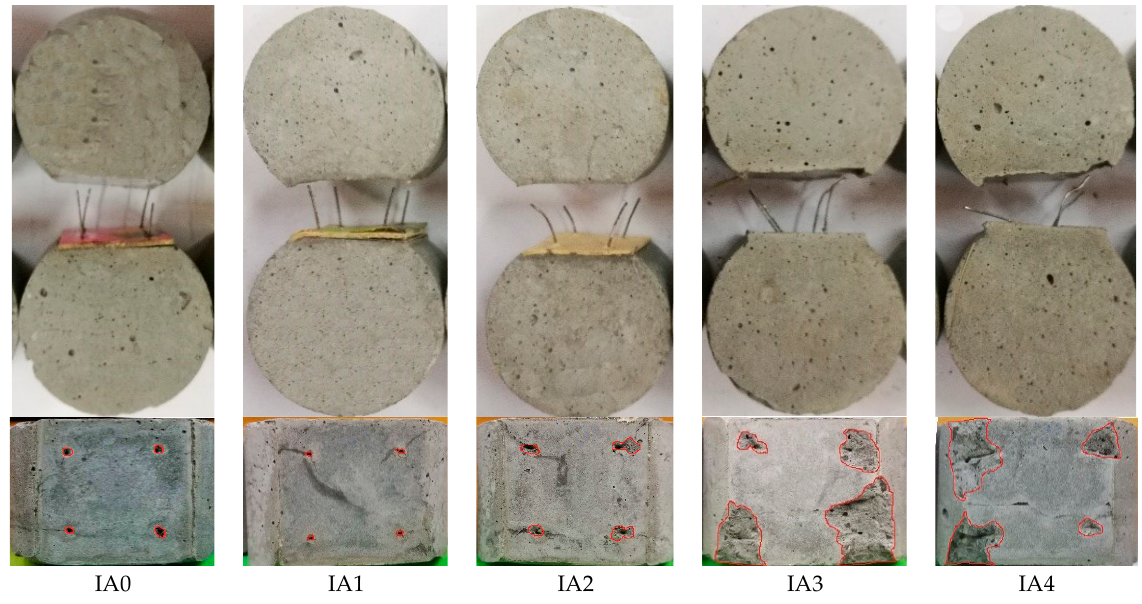
Figure 3. Typical failure mode of Series IA.